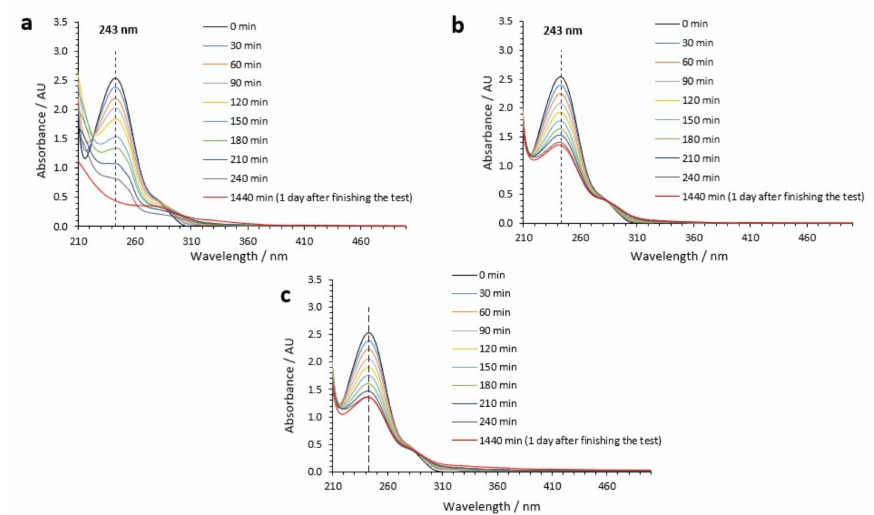
Figure 4. UV-visible absorption spectra obtained during PEC degradation of acetaminophen with TiO 2 photocatalysts anodized at Re = 600 (length = 6.1 µ m) for ( a ) pH 3, ( b ) pH 7, and ( c ) pH 9.